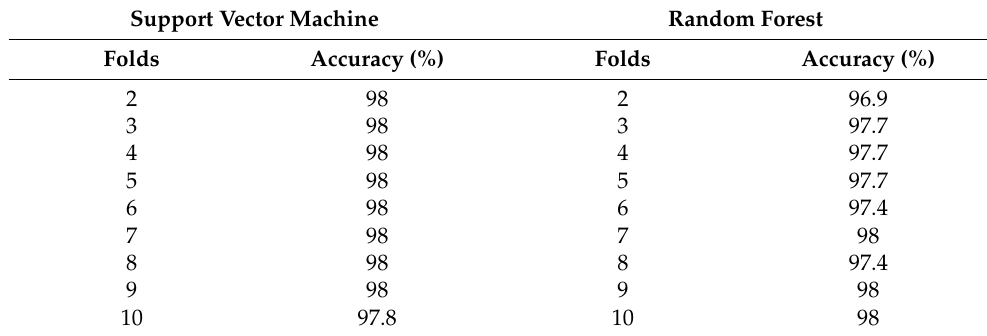
Table 6. Foldwise score of the trained